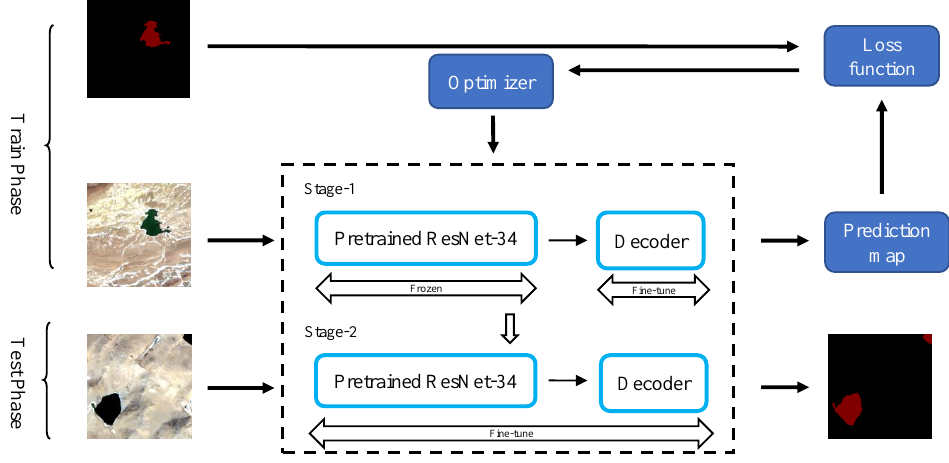
Figure 8. The training process proposed in this